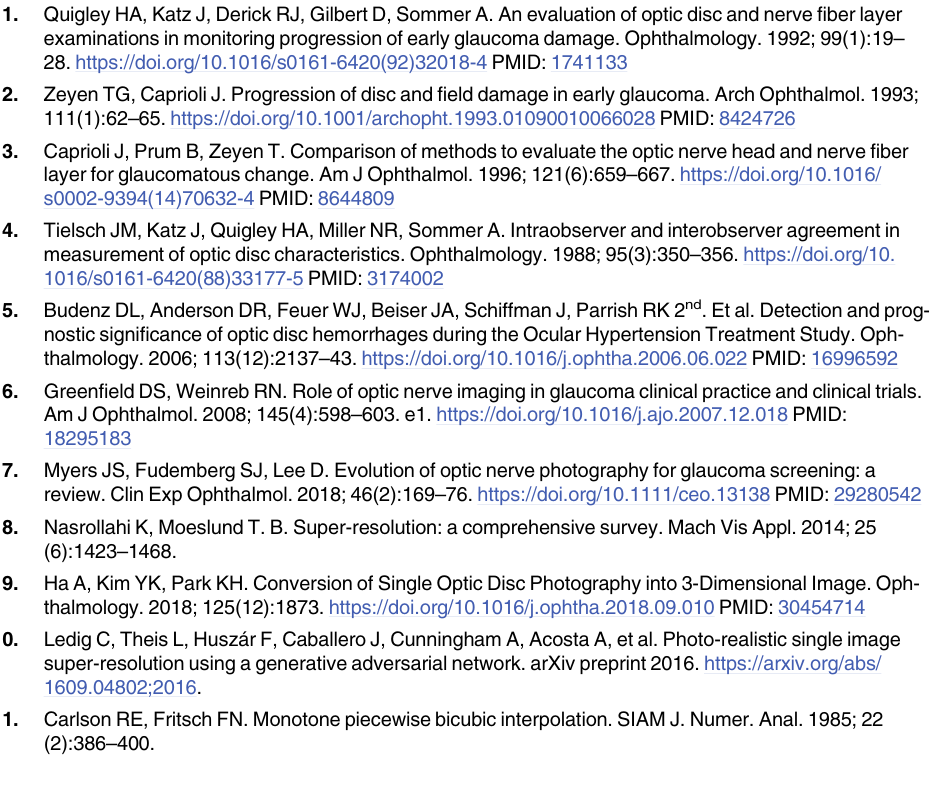
S3 Table. Mean opinion score (MOS) test results for representative test image sets. S4 Table. Demographic and clinical characteristics of study